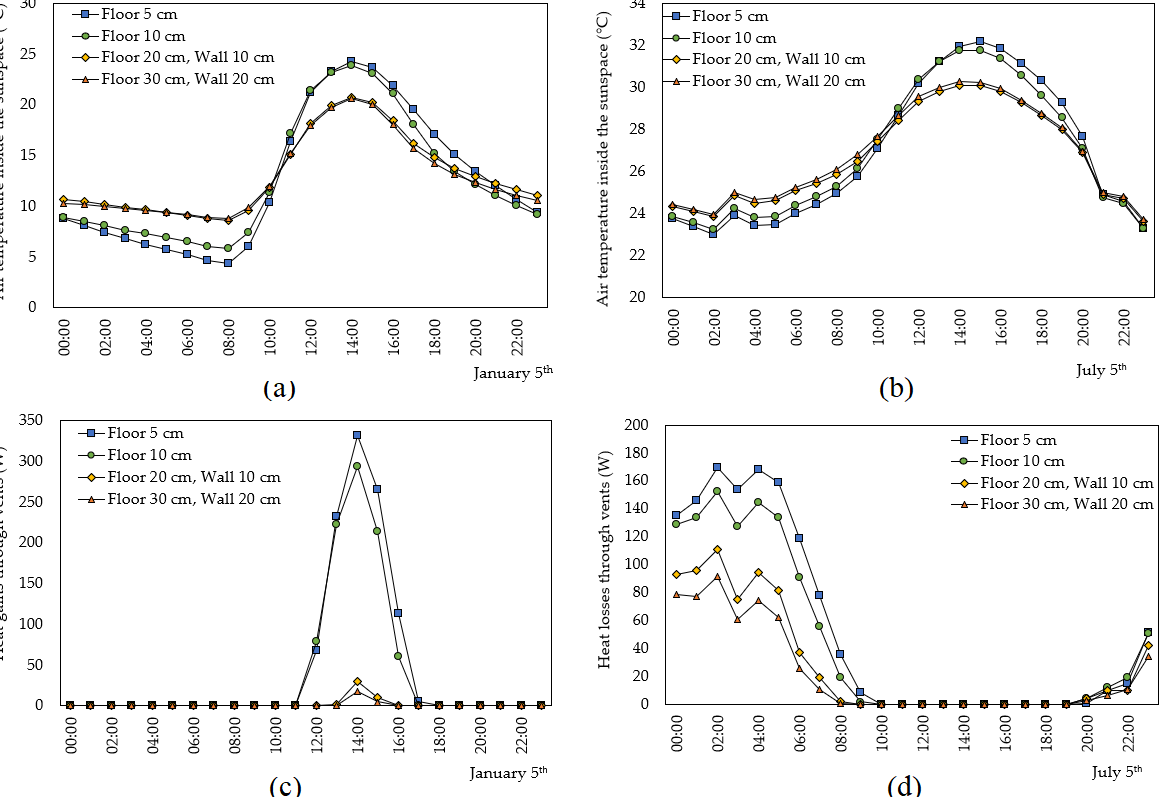
Figure 8. Heat storage mass analysis: ( a ) Air temperature inside the sun space (5 January); ( b ) air temperature inside the sunspace (5 July); ( c ) monthly average living room heat gains through vents (5 January); ( d ) monthly average living room heat losses through vents (5 July).